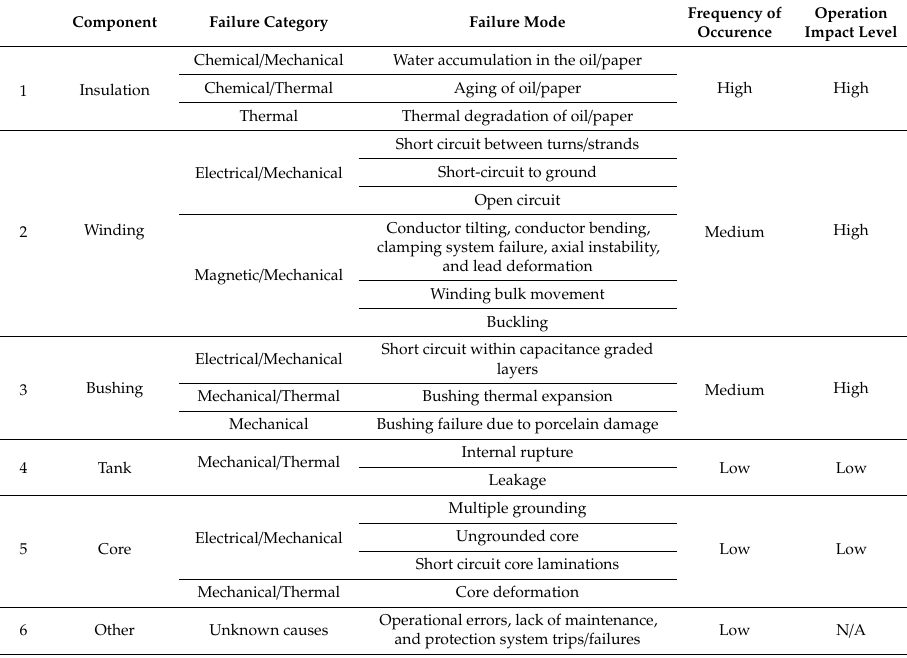
Table 1. Overhead distribution transformer failure modes.